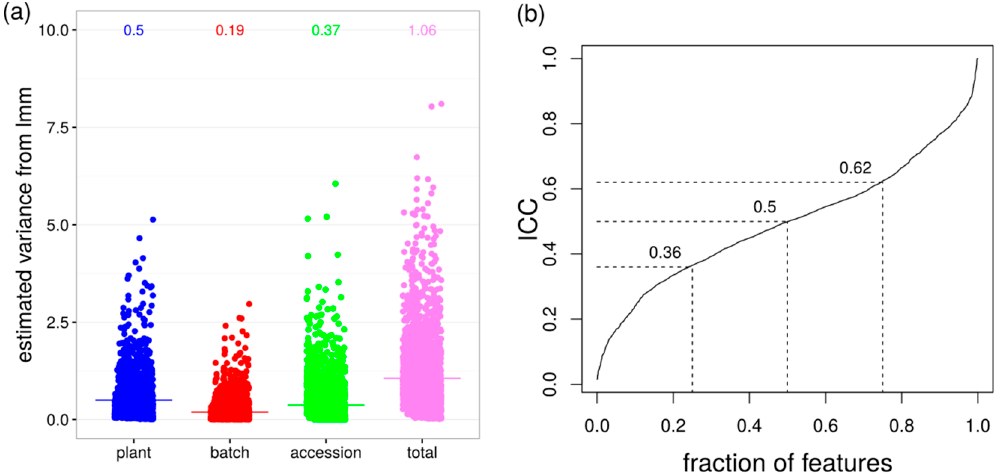
Figure 2. Variance decomposition of LC/electrospray ionization (ESI)( − ) MS data set. ( a ) Variances for plant, batch and accession were estimated with a linear mixed model (lmm), dot—variance of one feature, bar and number—mean variance over 2730 features; ( b ) cumulative intraclass correlation (ICC) distribution for all features ( σ 2plant / σ 2total ), dotted lines indicate 25%, 50% and 75% quantiles.